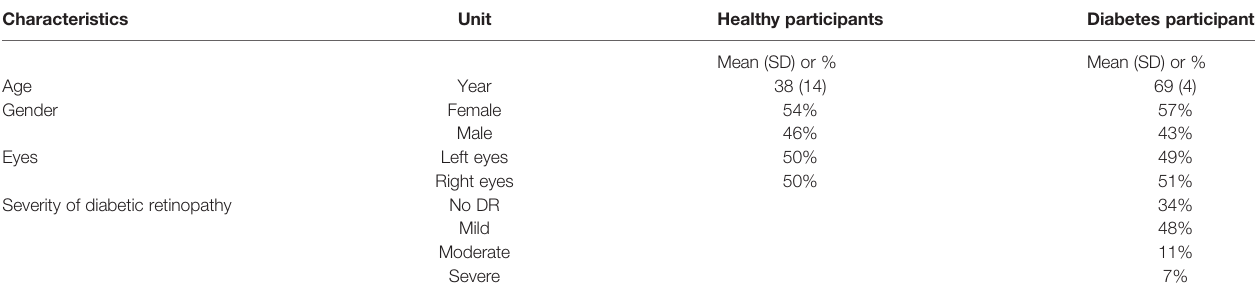
TABLE 1 | The characteristics of study